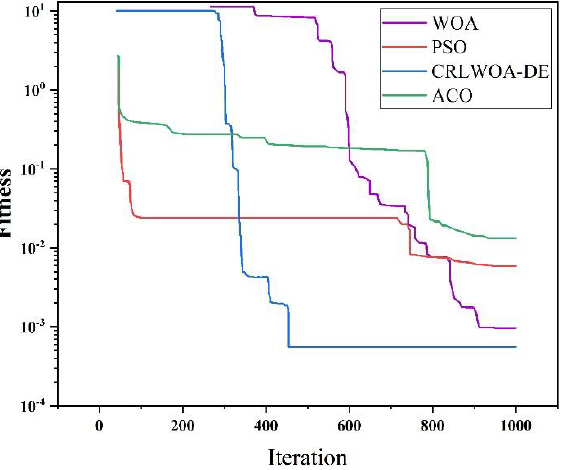
Figure 11. ACO, WOA, CRLWOA-DE, and PSO algorithm iteration results . Table 3. ACO, WOA, CRLWOA-DE, and PSO algorithm optimization results.